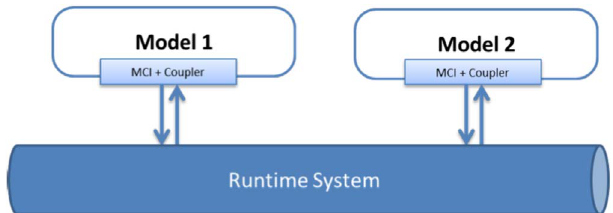
Fig. 3. Illustration of the run-time system taking models form the repository and linking them to each other via Model Coupling Interfaces.